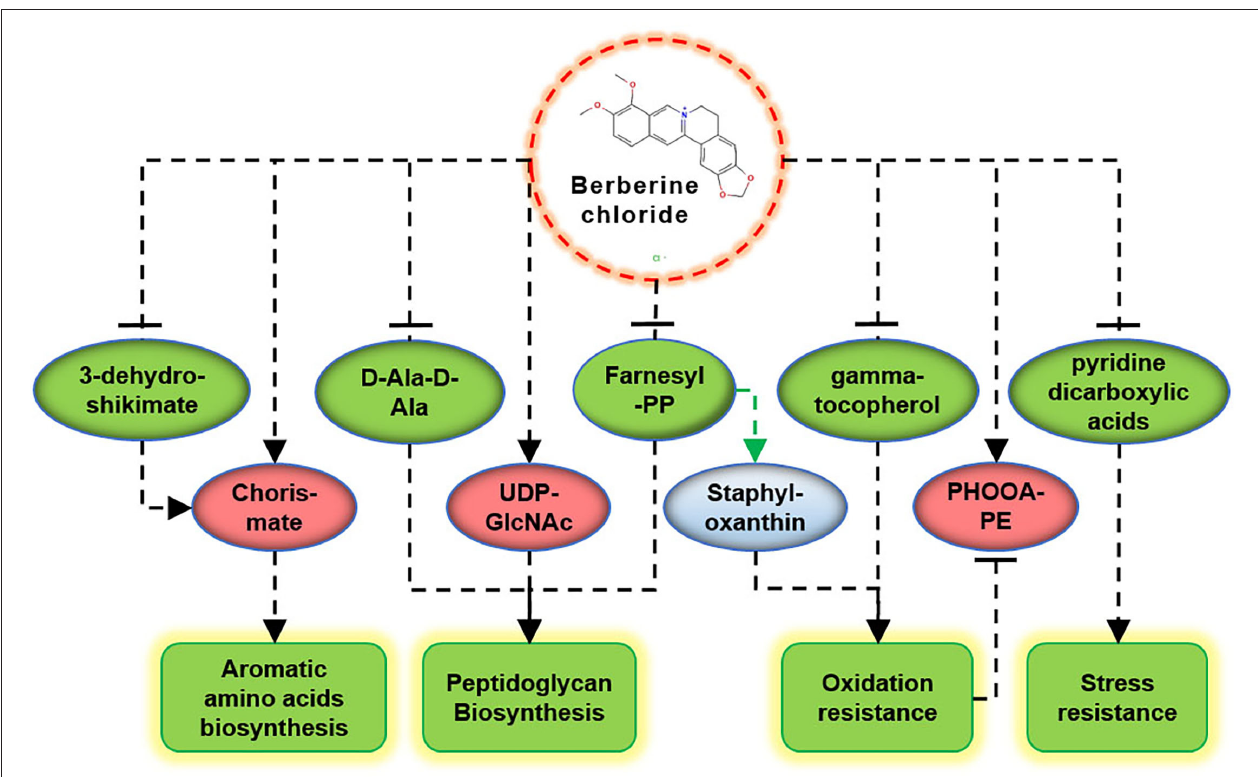
FIGURE 6 | Schematic diagram of the key metabolites in S. aureus in response to BBR exposure. Upregulation (promoting) and downregulation (inhibiting) are shown in red and green colors,